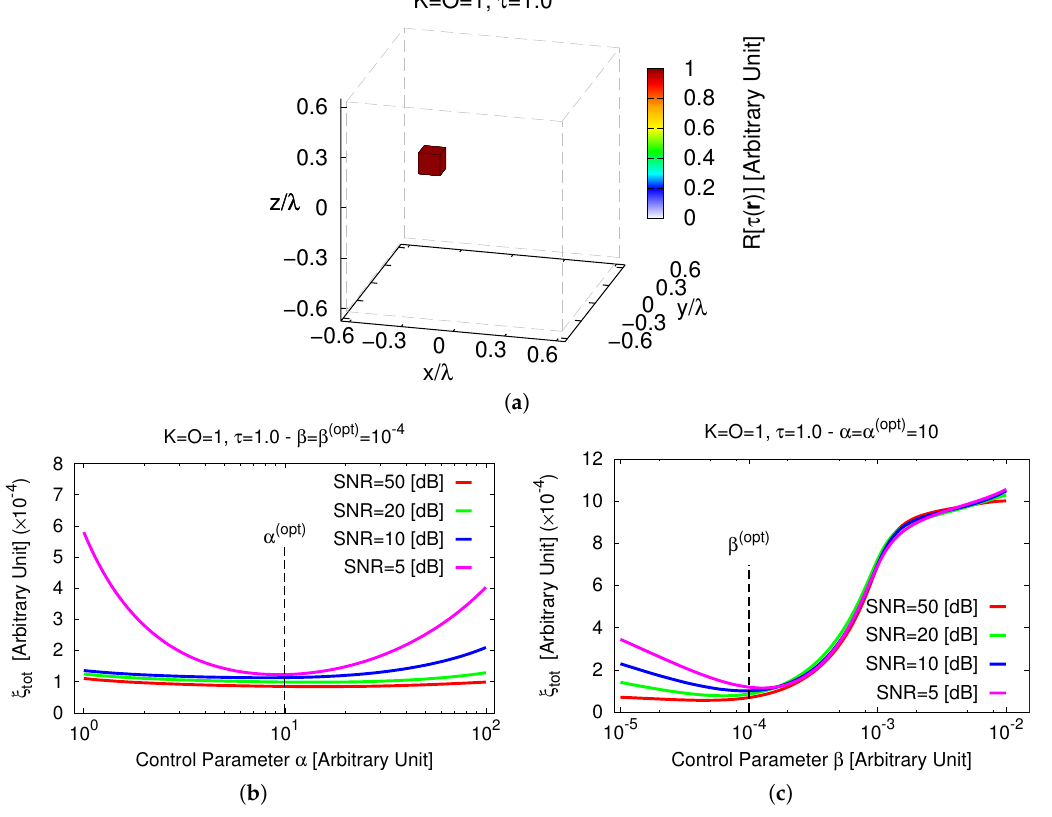
Figure 2. Sensitivity Analysis ( K = 1, O = 1, τ = 1.0, SNR ∈ [ 5, 50 ] [dB])—Actual contrast function ( a ). Behavior of the total error, ξ tot , versus the MT-BCS control parameters: ( b ) α ∈ ( β = β ( opt ) = 10 − 4 ) and ( c ) β ∈